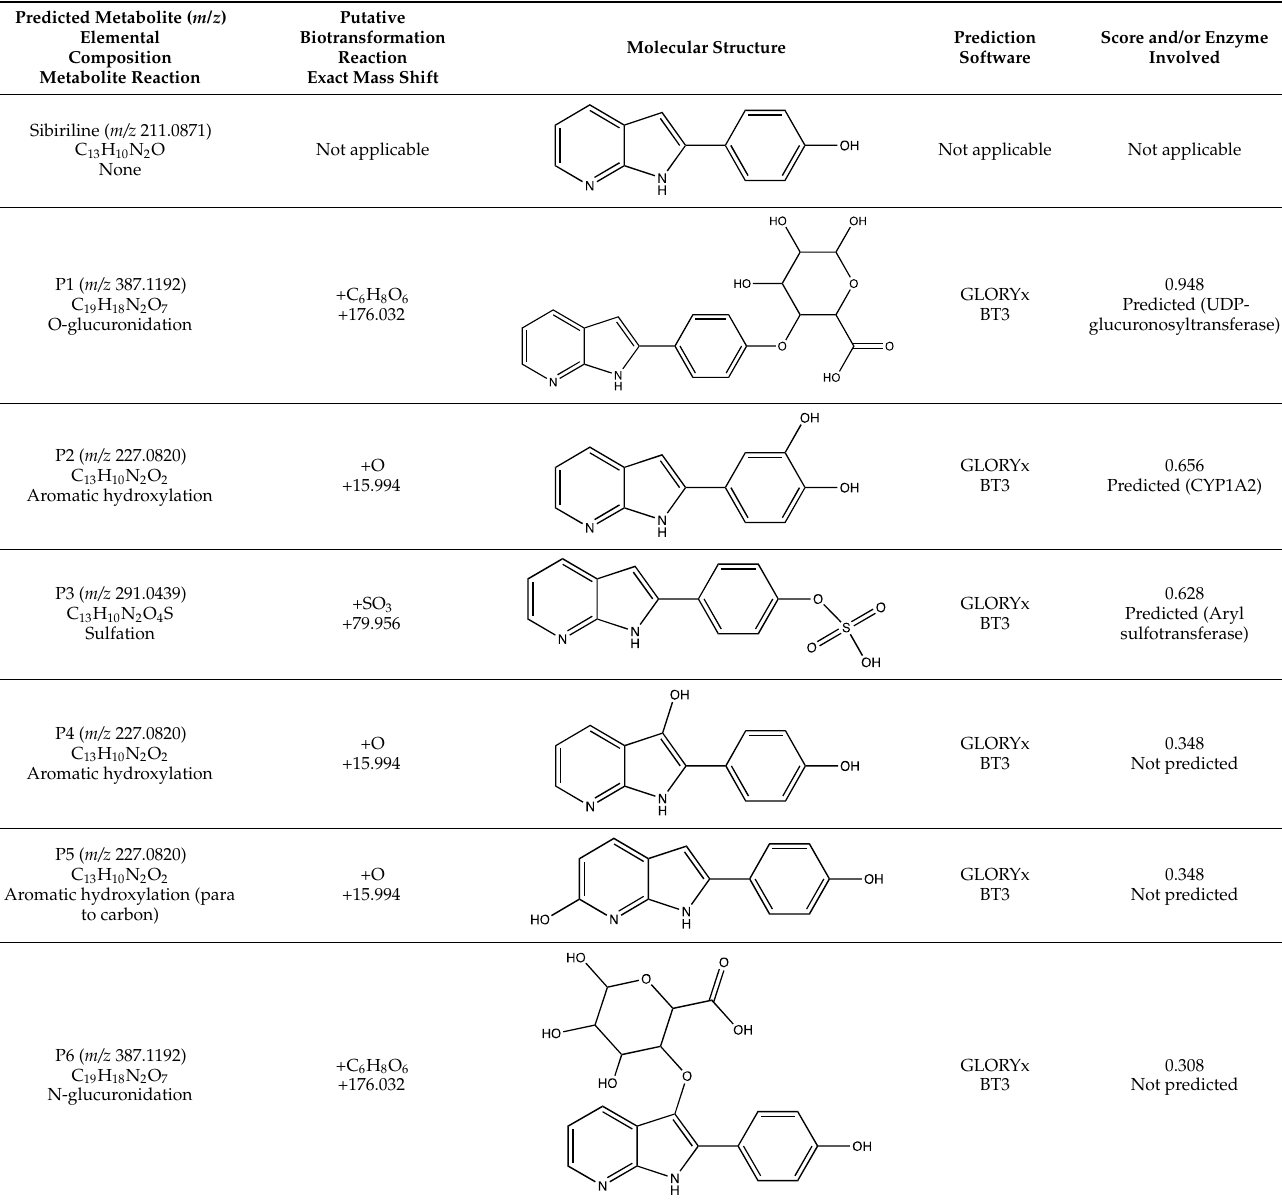
Table 1. In silico predicted sibiriline metabolites and associated m/z , molecular structure, elemental composition, metabolic reaction, exact mass shift, predictive score (GLORYx software) and enzyme predicted to be involved in biotransformation (BT3: Biotransformer 3.0).